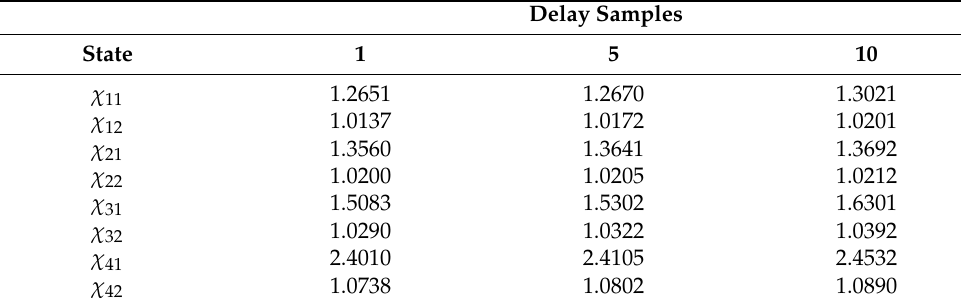
Table 2. Effect of time delay.